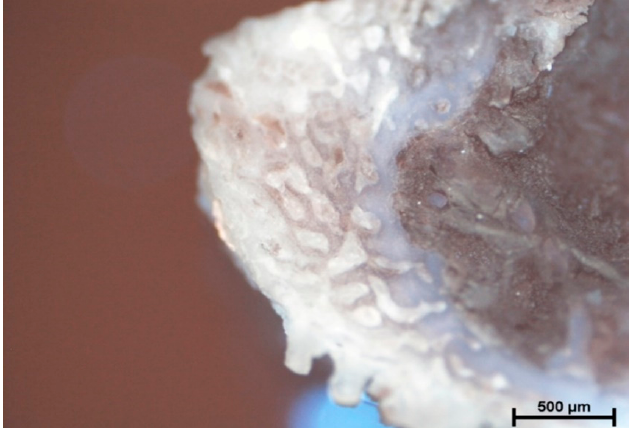
Figure 6. Rotation of 1500 rpm (without cooling). The apical area of rib filled with connective tissue. The lack of strong tissue compression areas caused by the drill.